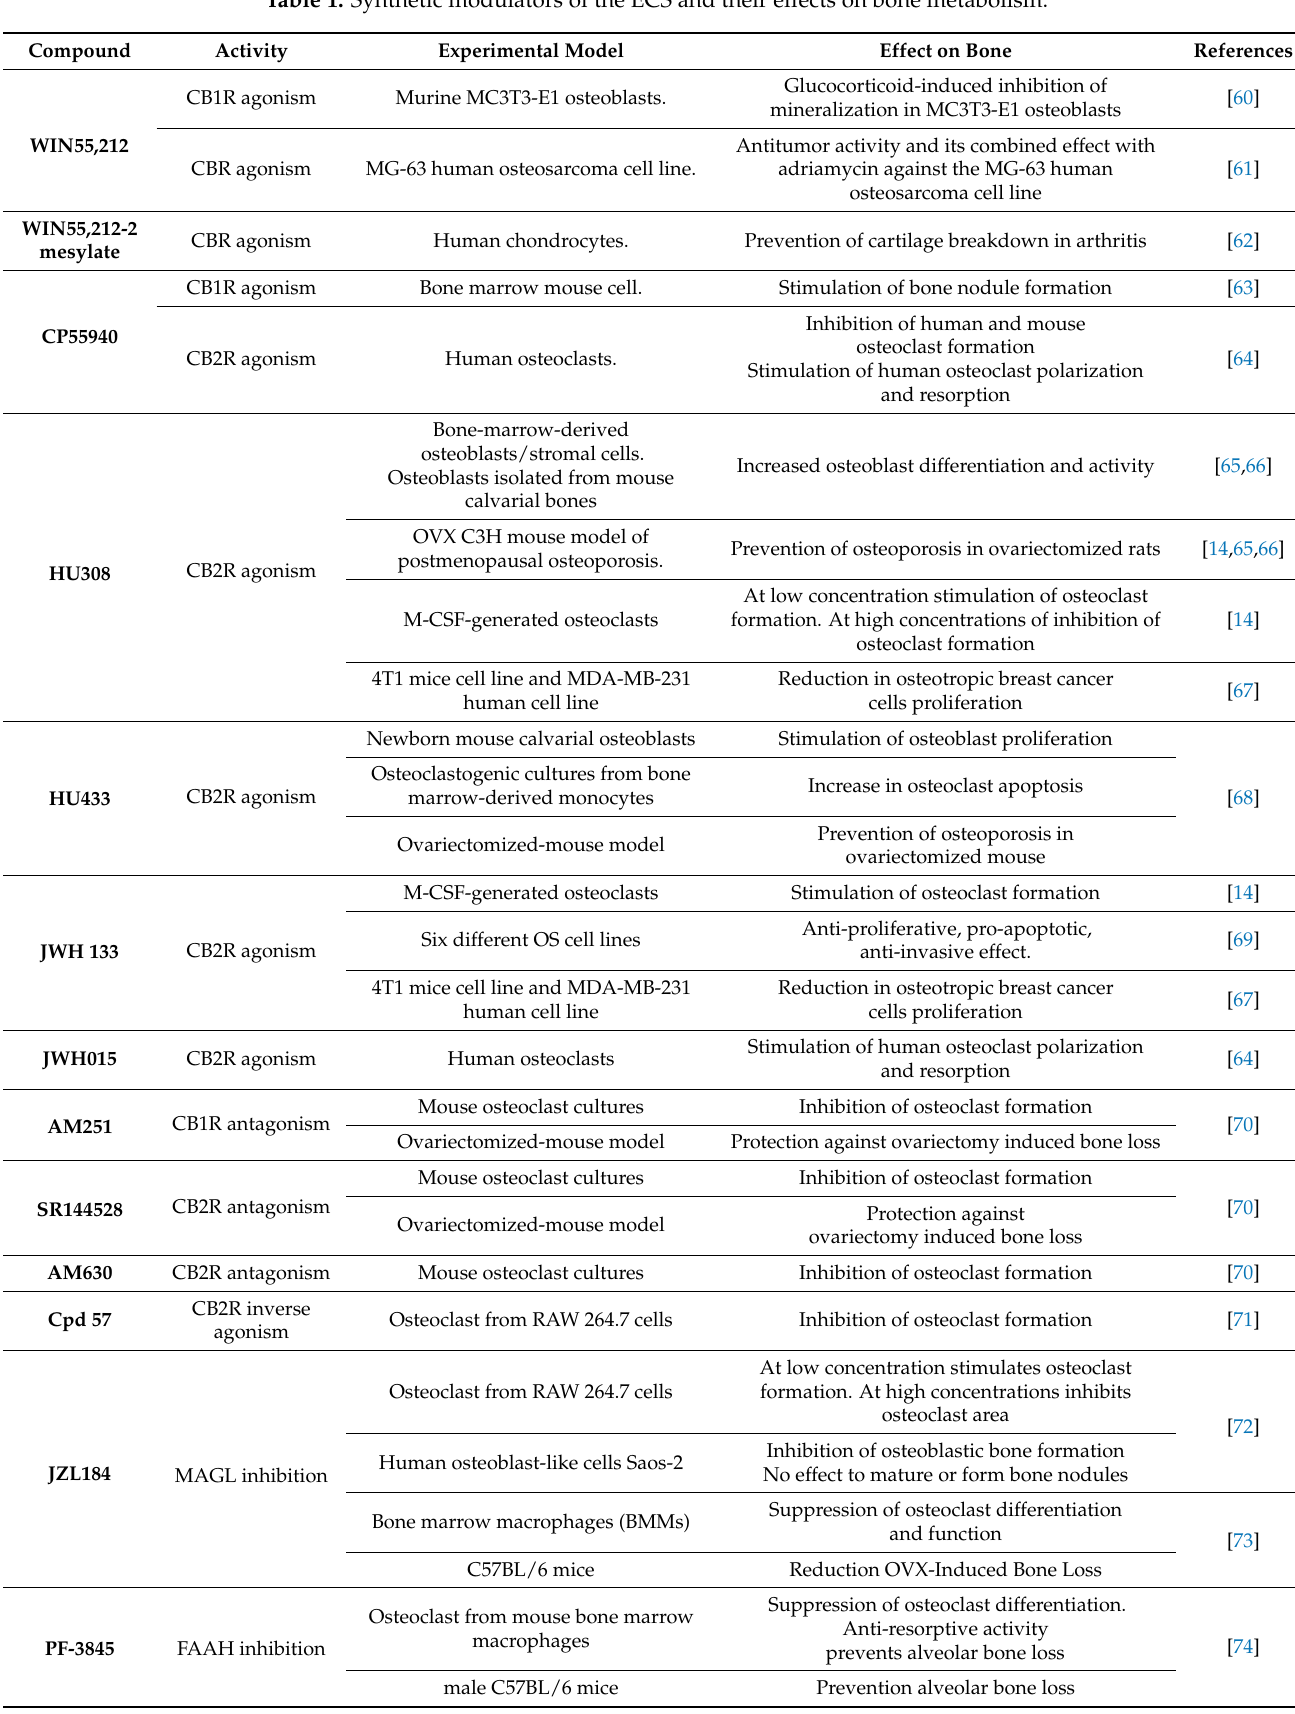
Table 1. Synthetic modulators of the ECS and their effects on bone